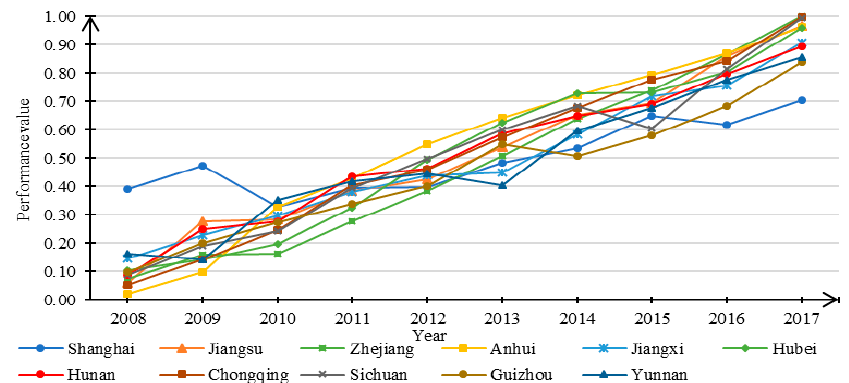
Figure 4. Trend in the performance levels of urbanization for 11 study regions from 2008 to 2017.